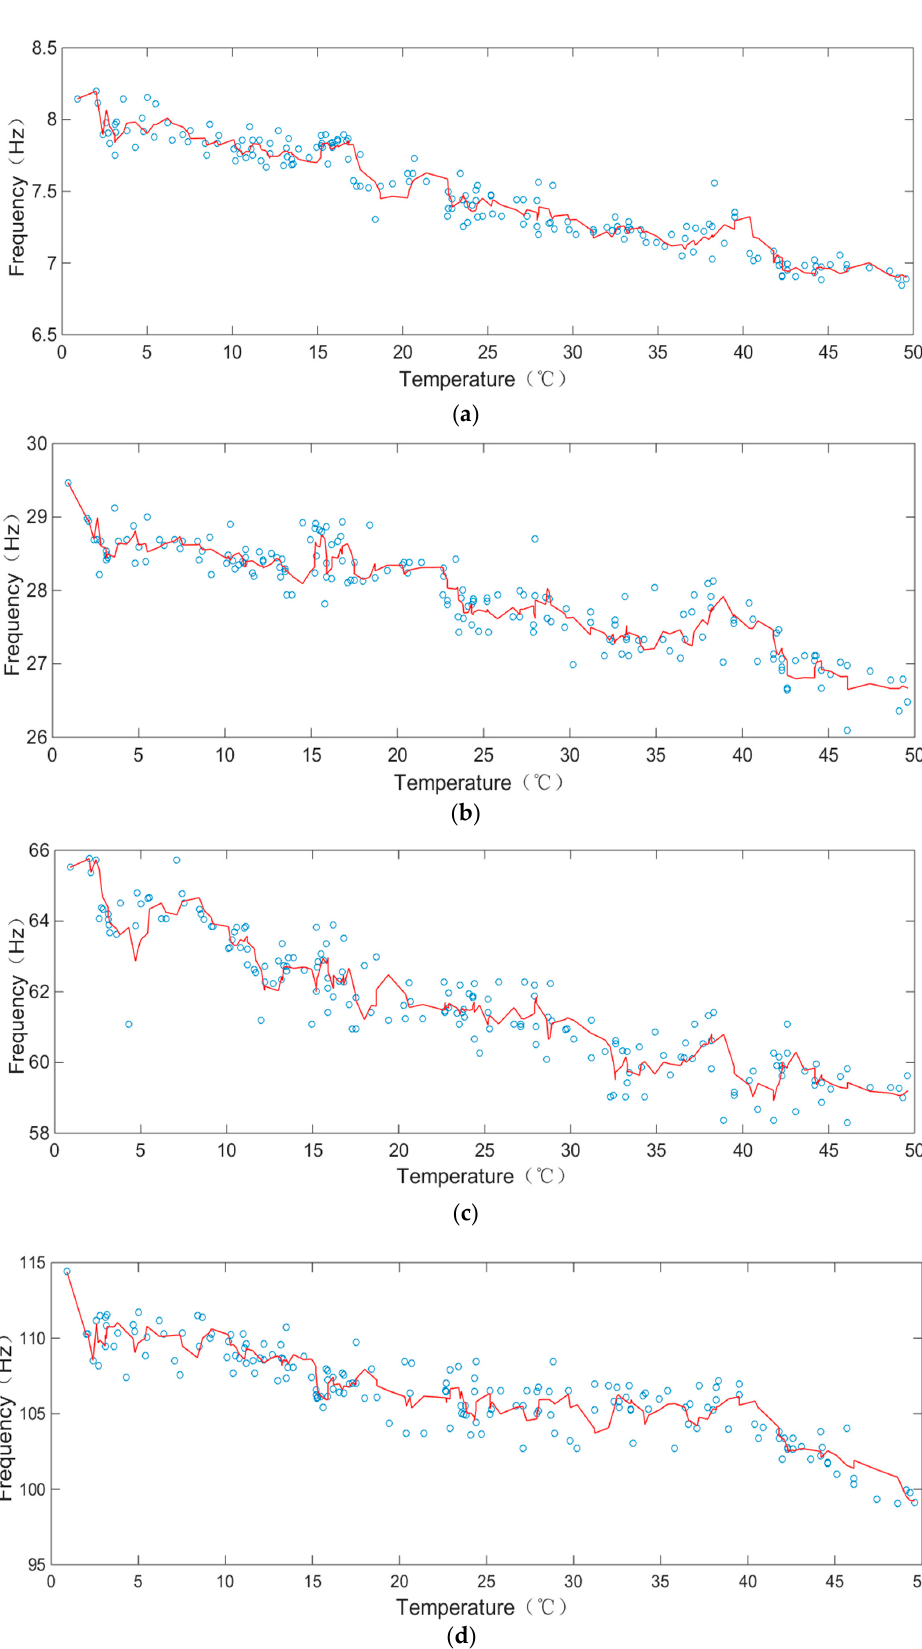
Figure 12. Autoregressive with exogenous input (ARX) models between temperature and natural frequencies. ( a ) 1st mode. ( b ) 2nd mode. ( c ) 3rd mode. ( d ) 4th mode.